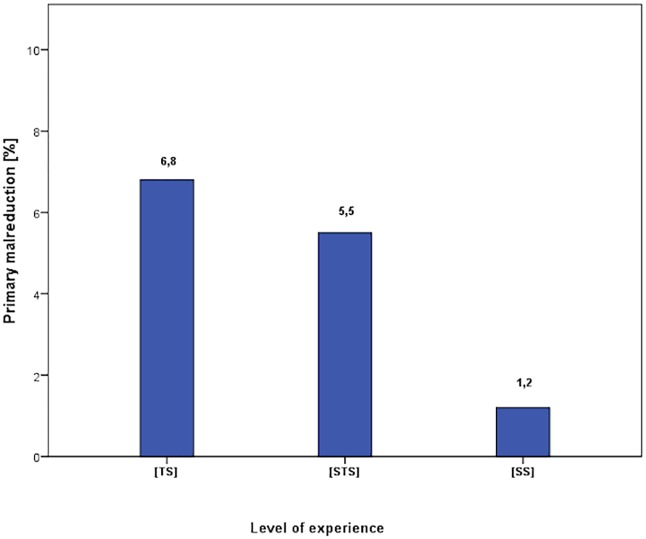
Distribution of primary malreduction and study exclusion rate.